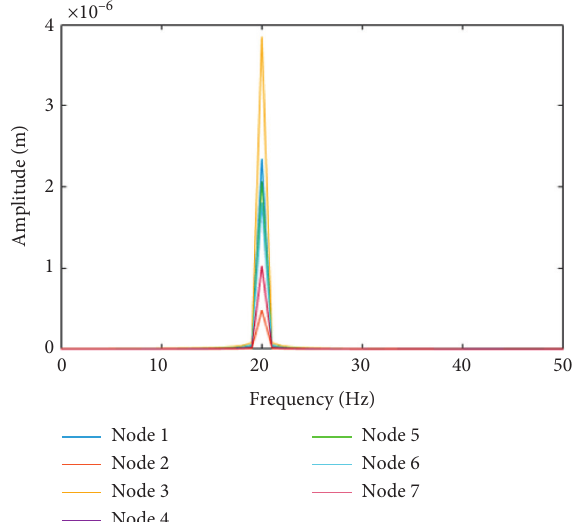
Figure 12: Frequency-domain characteristics of a single cylinder.